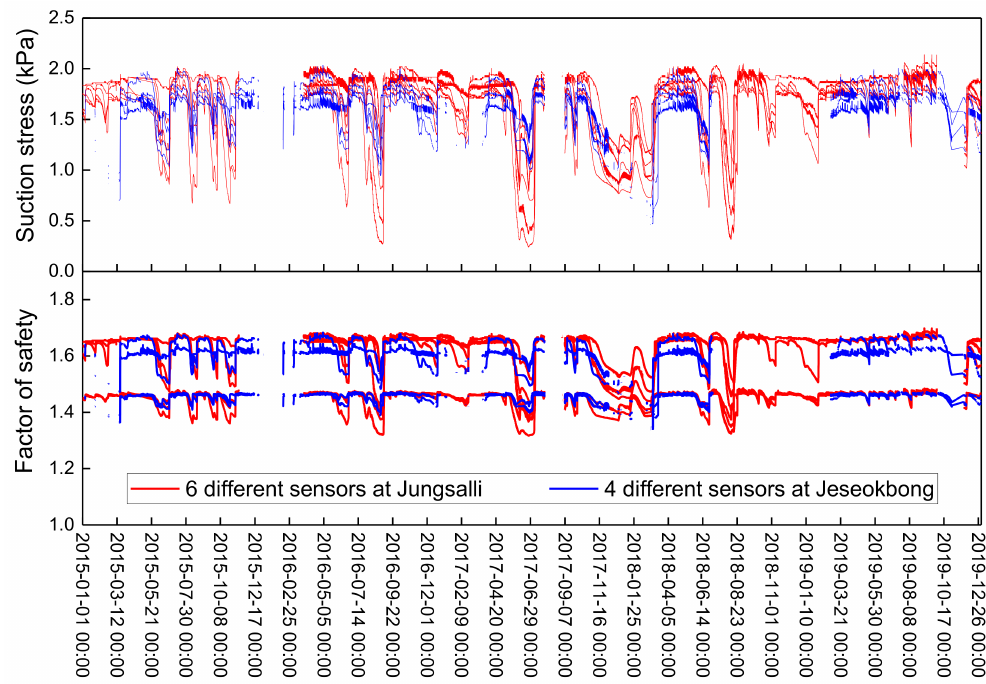
Figure 14. Suction stress and factor of safety calculation results of the Jeseokbong and Jungsalli